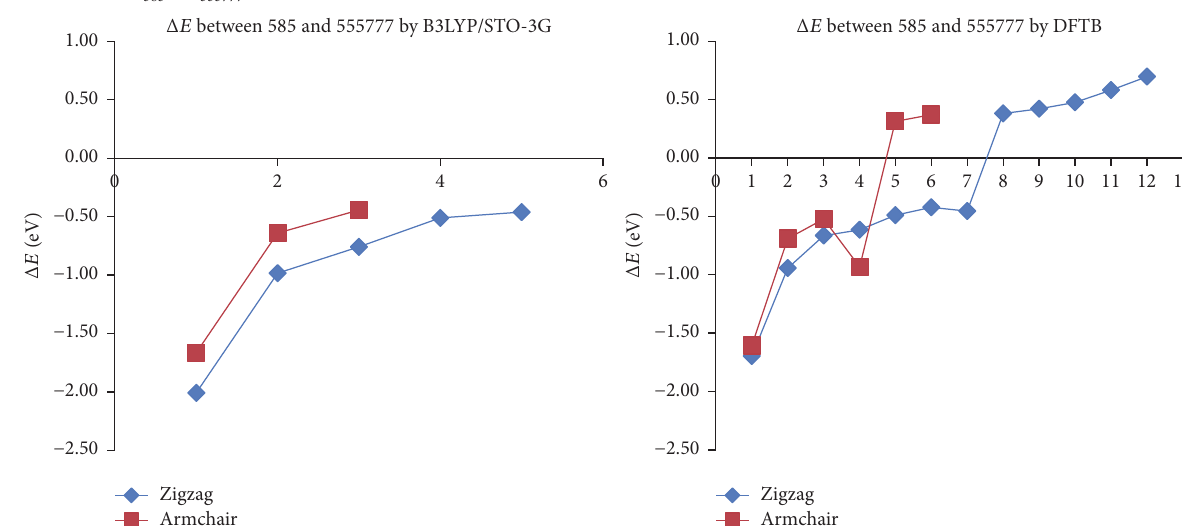
Figure 3: The energy differences between different types of divacancy defects (Δ𝐸 = 𝐸 585 − 𝐸 555777 ) in the same graphene flakes with B3LYP/STO-3G and DFTB methods.